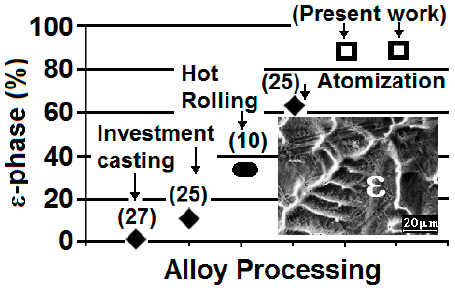
Figure 6. Percent of ε‐ phase as a function of alloy processing. Figure 7 is an SEM micrograph of the athermal ε‐ martensite developed within the columnar dendritic structure in a Co ‐ 20 wt. % Cr alloy; in particular, notice the typical striations associated with the athermal ε‐ martensite transformation [28]. The exhibited microstructure was further investigated by TEM means.